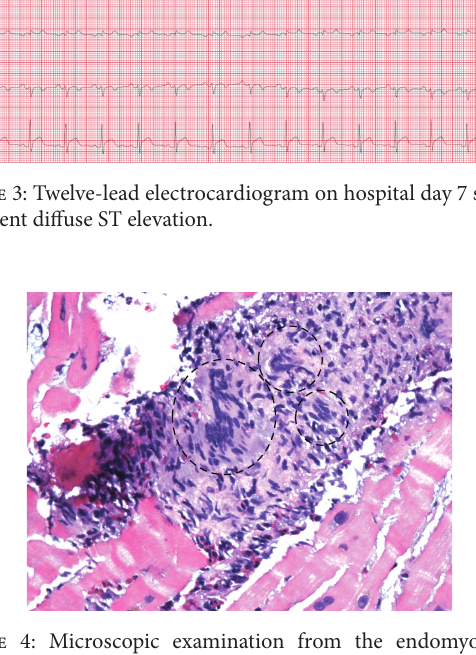
Figure 4: Microscopic examination from the endomyocardial biopsy of the right ventricle showing myocardial necrosis with inflammatoryinfiltratecontainingmultinucleatedgiantcells(within circled areas) (H&E, orig. ×